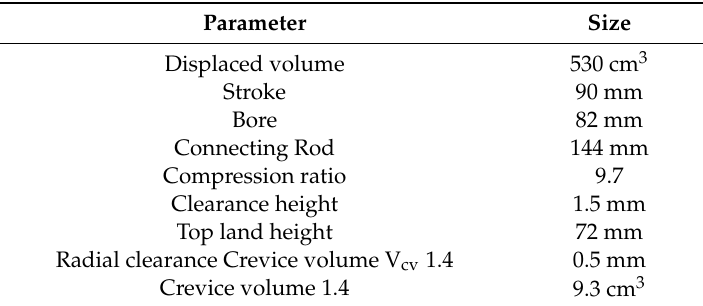
Table 1. Specifications of the PFI SI single-cylinder research